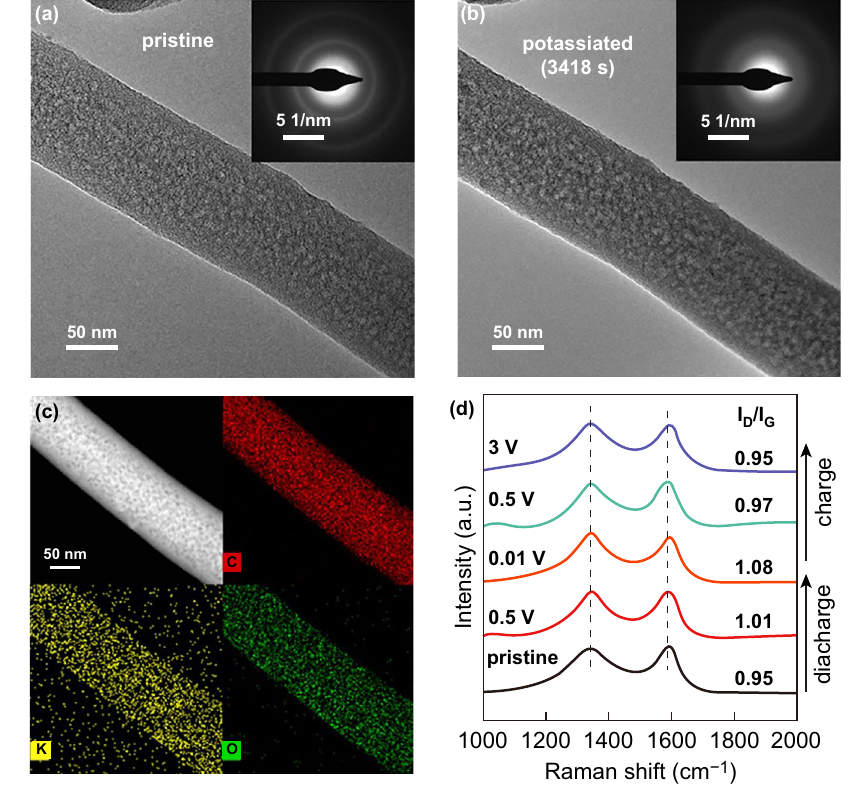
Fig. 4 Structural evolution during potassiation and depotassiation. In situ TEM images and SAED patterns of a pristine and b potassiated meso-C nanowires. c HAADF-STEM image and the corresponding EDX mappings of potassiated meso-C nanowire. d Ex situ Raman spectra of